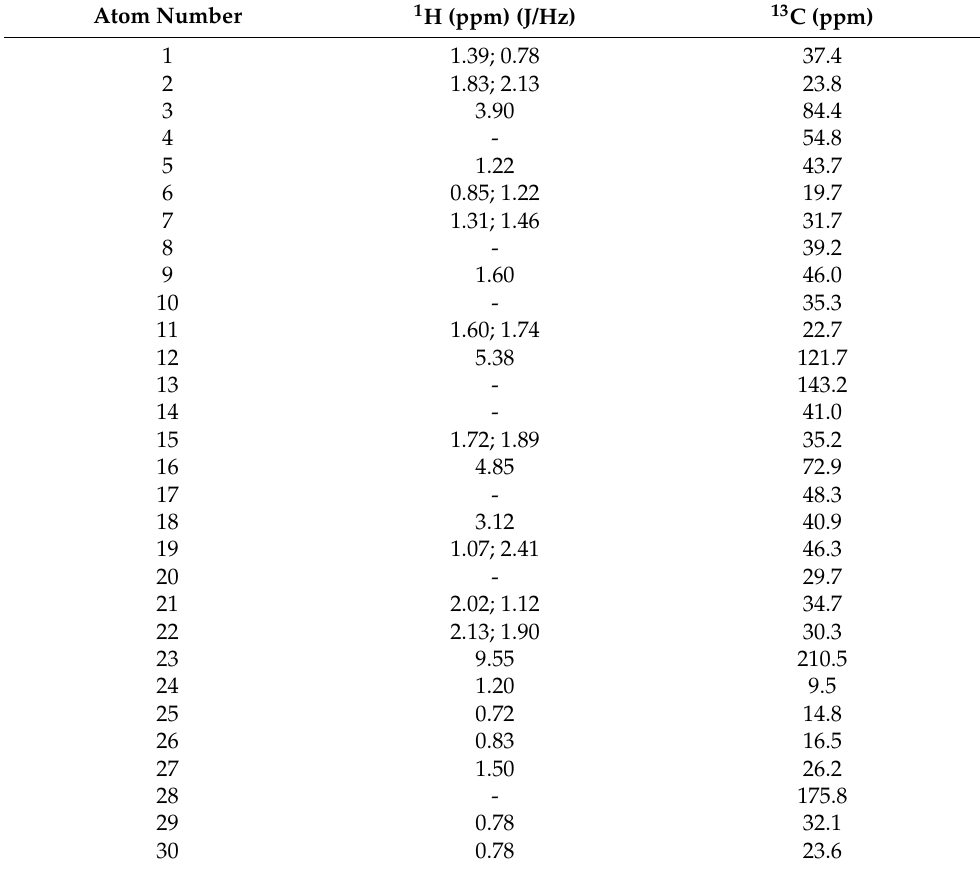
Table 1. 1 H and 13 C data (ppm) for the aglycone moiety in GOTCAB; 1:1 pyridine_d5/D 2 O. Atom Number 1 H (ppm)